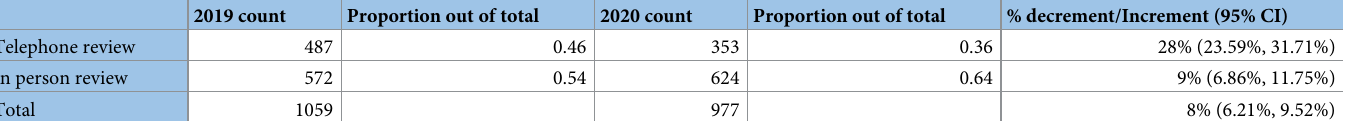
Table 4. Day-cases based episodes reviewed over the phone during the study period compared to 2019.